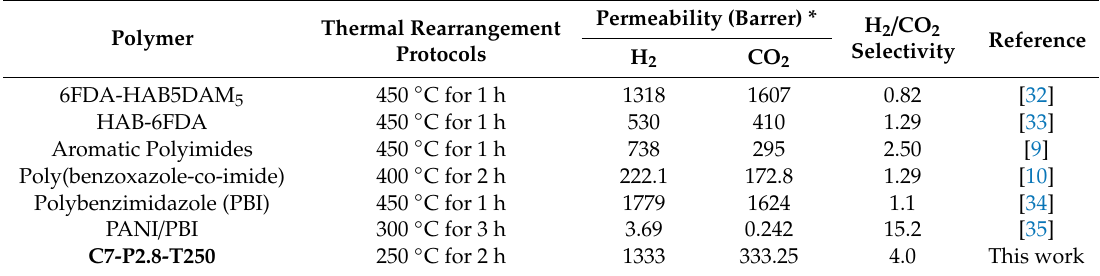
Table 2. Comparison of rubber-derived TR membrane with other reports with respect to hydrogen permeability and H 2 / CO 2 selectivity.